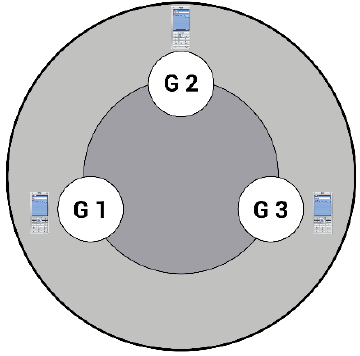
Figure 2. Computer Supported Collaborative Learning (CSCL) Mobile Model.